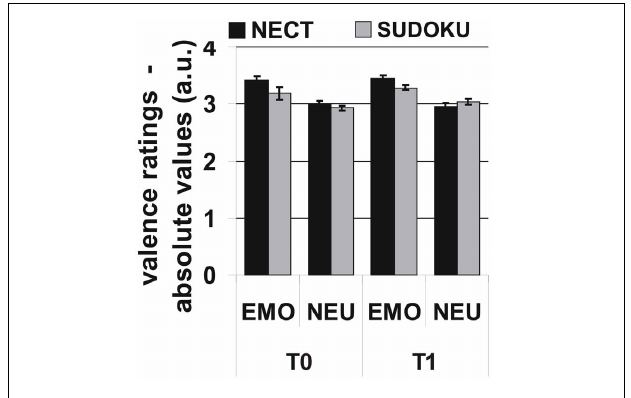
FIGURE 1 | Behavioral responses: More extreme absolute valence ratings for emotional than for neutral stimuli, but no systematic influence of training type or time point on valence ratings or respective interactions. Note: Initial rating scale: [ −− − + ++ ] transformed to numeric values (1–4). Neutral = 2.5; absolute valence ratings relative to “neutral” are given for emotional